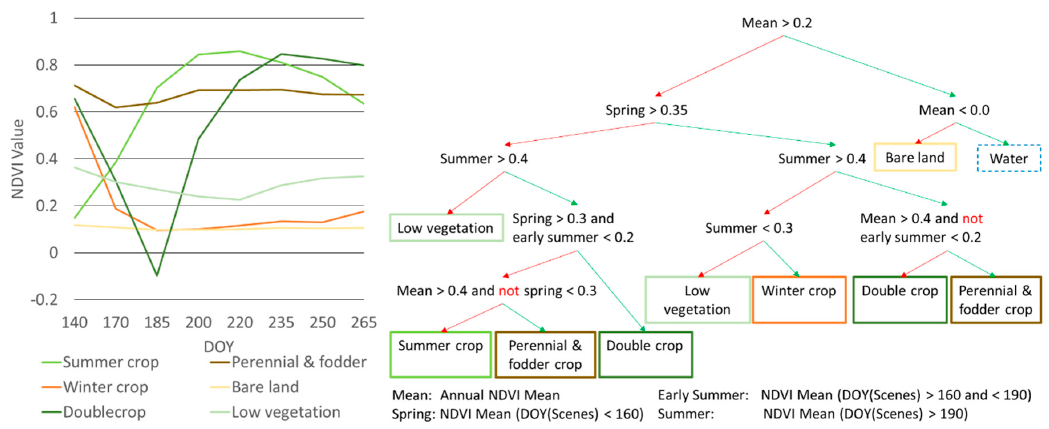
Figure 6. Landsat NDVI profiles of the six distinguished classes ( left part ) and the decision tree through which the classes were mapped ( right part ), and of which the HR-CVP maps were composed (within the HR-iCE maps). This example shows data of reference site 157-033 recorded in 2007 (see also Figure 3). DOY = Days of year that describe the start and end dates of the different observation periods (referring to the respective Landsat product identifier).